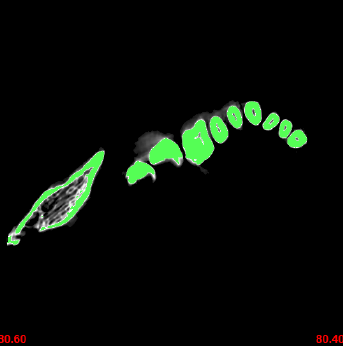
Figure 6. Tomographic slice with specified threshold level for digital model generation